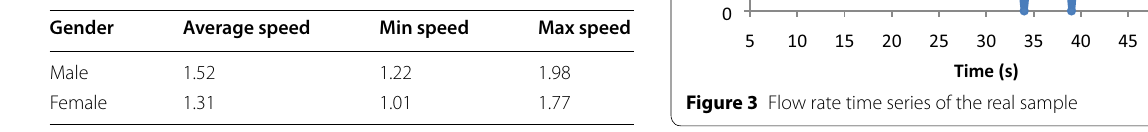
Table 1 Minimum and maximum free walking travel speeds during egress trials (m/s)